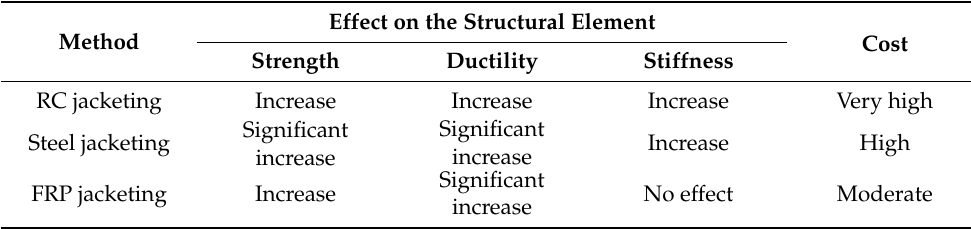
Table 3. Comparison of the main characteristics of the described jacketing methods.